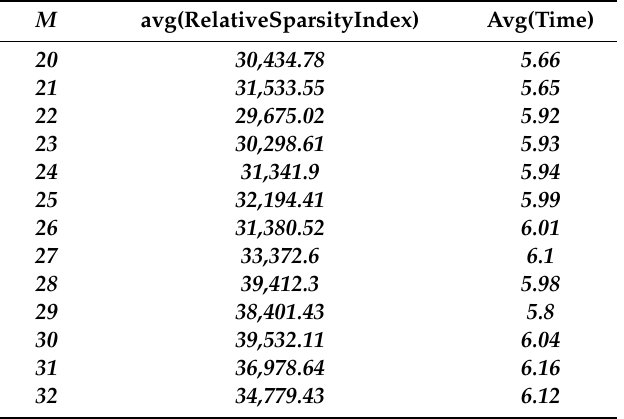
Table A1. Summary of the most significant tests, where M represents the sample size (number of the selected peers), the second column represents the randomness index of the sample and the third column represents the average amount of time spent by the blockchain to obtain an